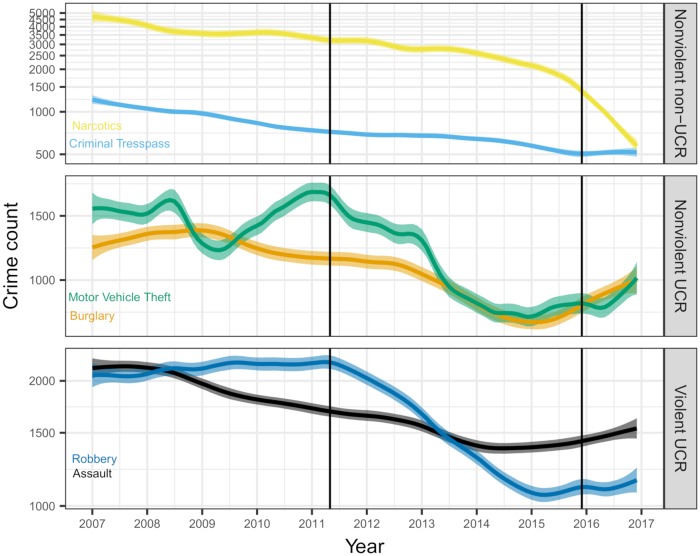
Smoothed time series means and 95% pointwise credible intervals for monthly crime counts of robberies, burglaries, assaults, motor vehicle thefts, criminal trespasses, and narcotics crimes in Chicago from January 2007 to December 2016.Changes to the police superintendent are indicated (vertical lines).